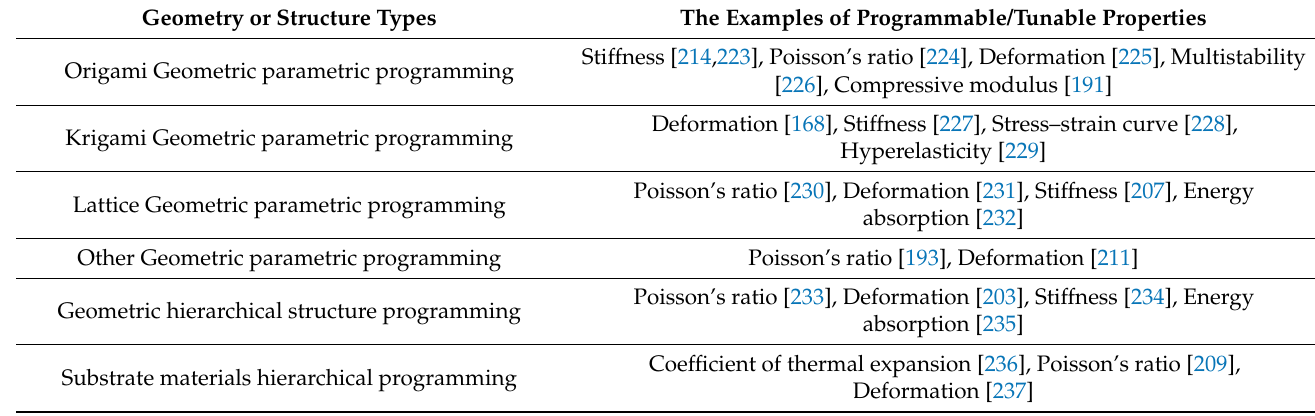
Table 5. Examples of programmable mechanical properties based on geometry or structure.